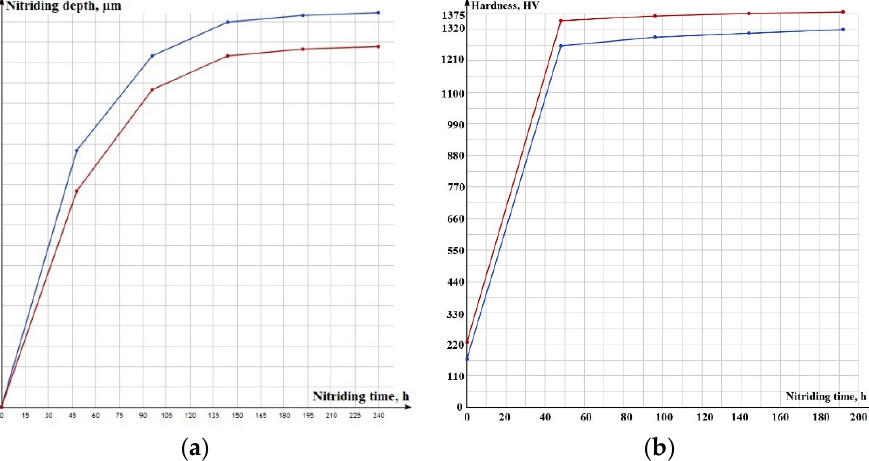
Figure 8. Dependence of the depth and hardness of the nitrided layer on the nitriding time. Blue line = conventionally manufactured specimens. Red line = specimens made by the LB-PBF. ( a ) Layer depth and ( b ) layer hardness.